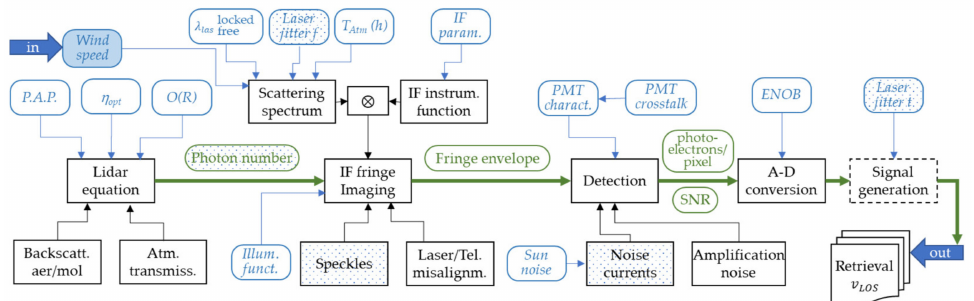
Figure 2. Synopsis of the physics-based end-to-end simulation. Black boxes indicate modules of physical or technical processes, blue rounded boxes relate to adjustable inputs. Green rounded boxes refer to the basic variables (variable arrays) handed over between modules. Dot patterns indicate implemented random processes or inputs. More details in the